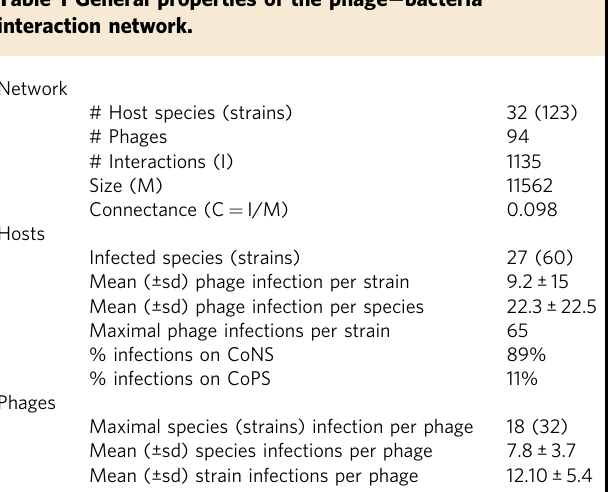
Table 1 General properties of the phage − bacteria interaction